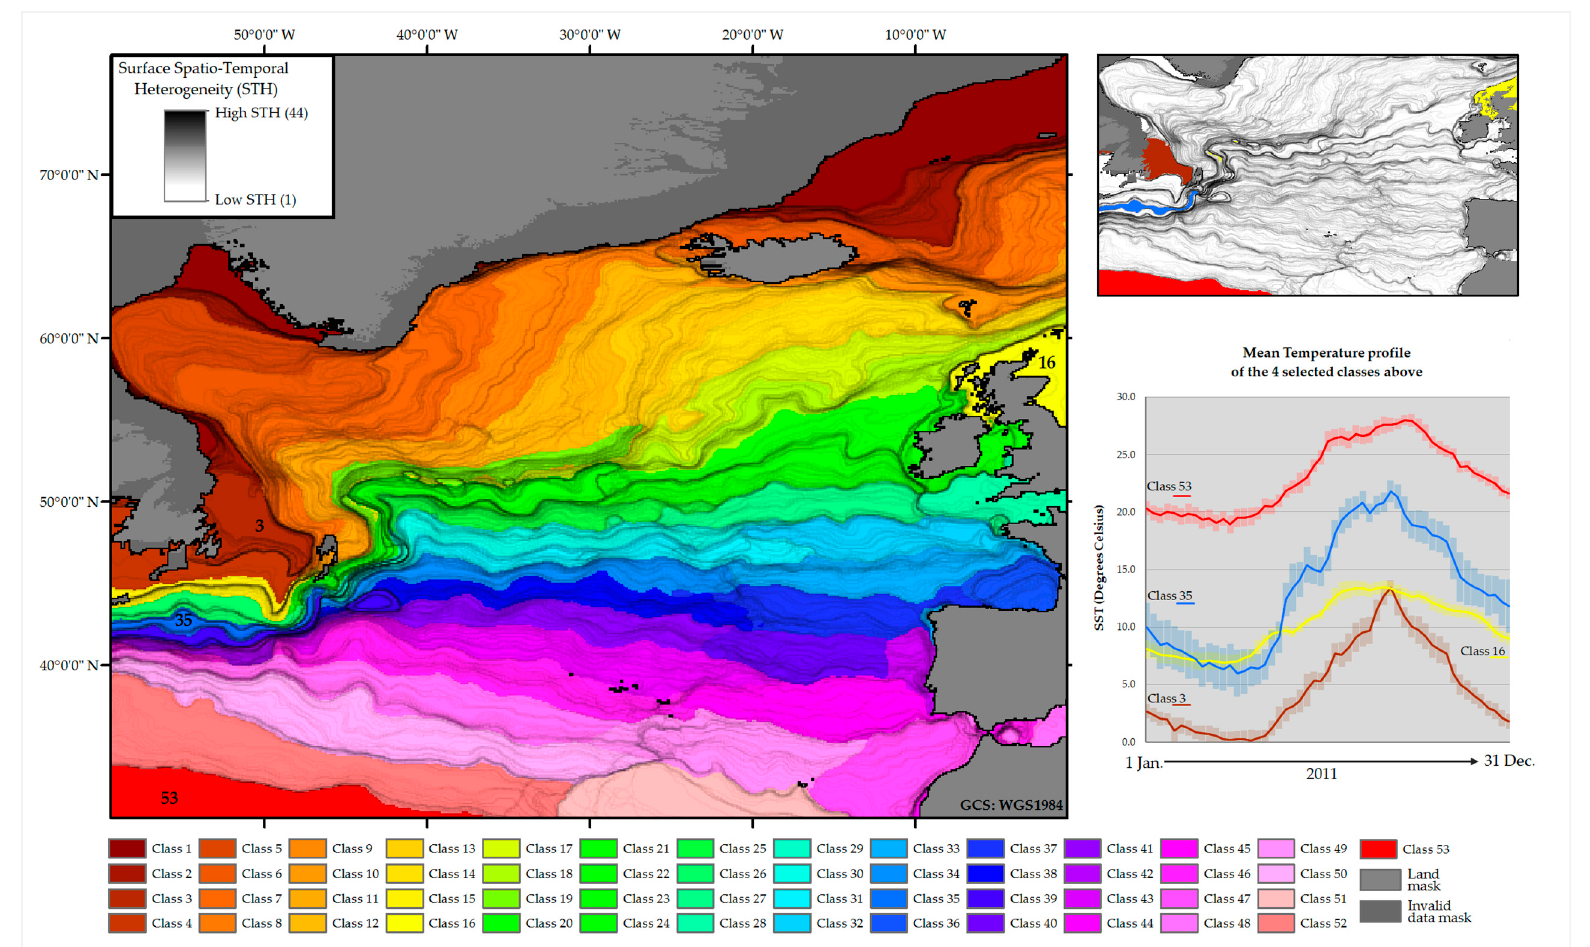
Figure 8. The STH map product combining the STH dataset, with a class map generated using the optimal cluster image and signature data. The colours represent different classes, each with a unique temporal SST signature. The temporal profiles of select classes are shown using the mean and standard deviation (error bars) in SST over 2011. Four classes are highlighted to show their spatial and temporal characteristics—Class 3 in the cool waters to the east of Canada, Class 16 in Scottish waters (both the North Sea and NE. Atlantic), Class 35 in the western Atlantic meandering Gulf Stream, and Class 53 in the warmer waters of southern N. Atlantic.